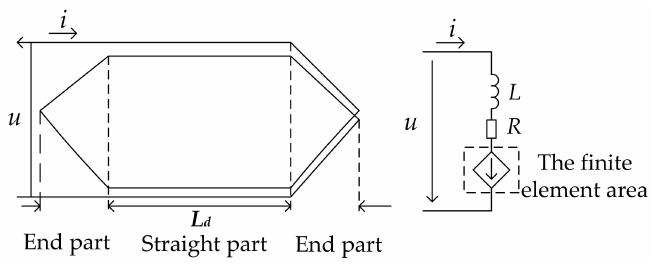
Figure 3. Equivalent model of field-circuit